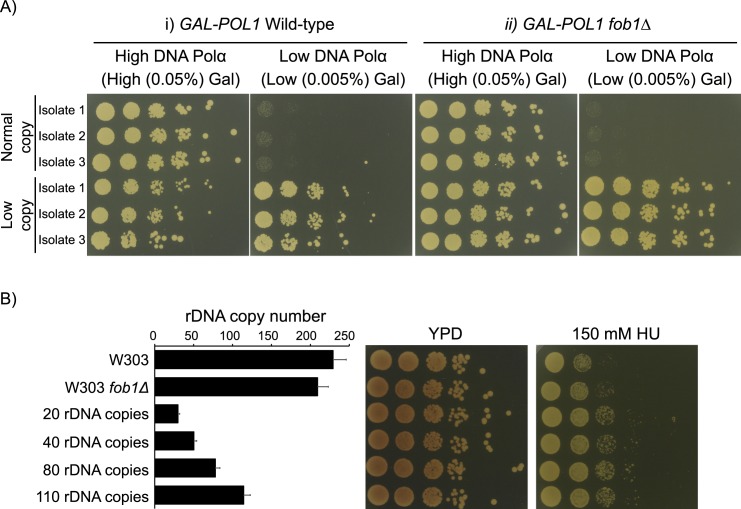
Low rDNA copy number confers advantage under DNA replication stress.(A) 3 independent isolates each with normal or low rDNA copy number were generated by subcultuing wild-type or fob1Δ GAL-POL1 cells in medium containing high or low galactose (high or low levels of Pol1 respectively) for ~50–75 generations (S2 Table) and 5-fold serial dilutions spotted on to medium with DNA replication stress (low Pol1). (B) 10-fold serial dilutions of wild-type and fob1Δ cells (~200–250 rDNA copies) along with cells having 20–110 rDNA copies [3] were spotted on medium containing hydroxyurea (HU). rDNA copy number was confirmed by ddPCR. Error bars represent standard deviation for each individual reaction.